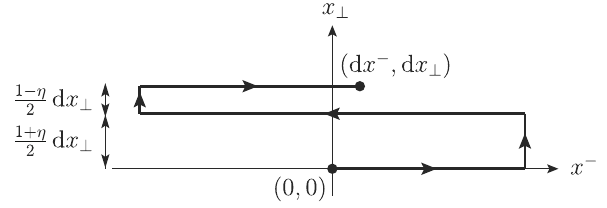
Fig. 1 Path C defining A value of the parameter η ∈ [− 1 , 1 ] . An alternative (but equivalent) path would first go to −∞ − and then to +∞ −